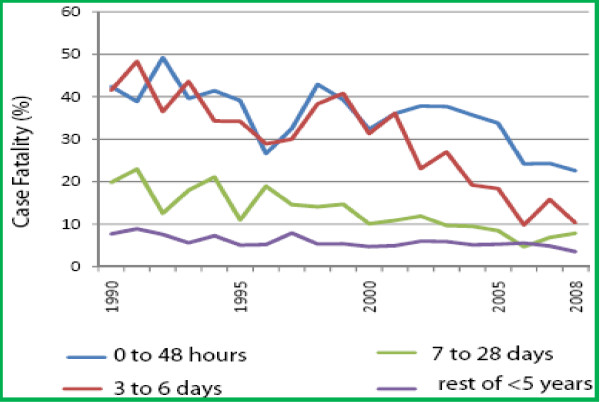
Displaying trend in inpatient case fatality for neonates aged ≤ 48 hrs, 3 to 6 days and 7 to 28 days at admission and the rest of the paediatric admissions ≤ 5 years.